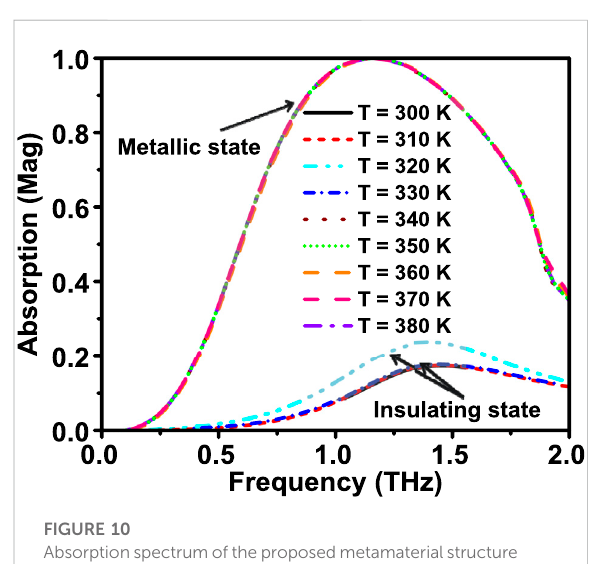
FIGURE 10 Absorptionspectrumoftheproposedmetamaterialstructure atdifferenttemperaturesofVO2intheinsulatingstateandmetallic